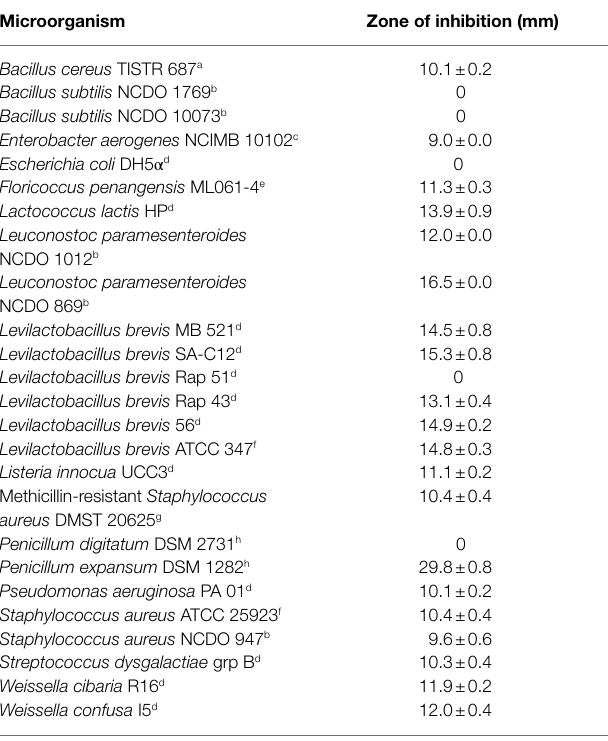
TABLE 1 | Antimicrobial activity of cell-free supernatant (CFS) produced by B. velezensis ML122-2 against indicator microorganisms. Microorganism Zone of inhibition